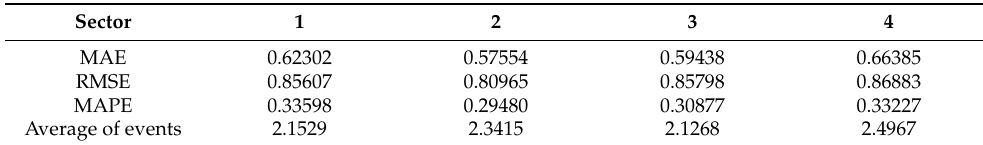
Table 2. Regression model